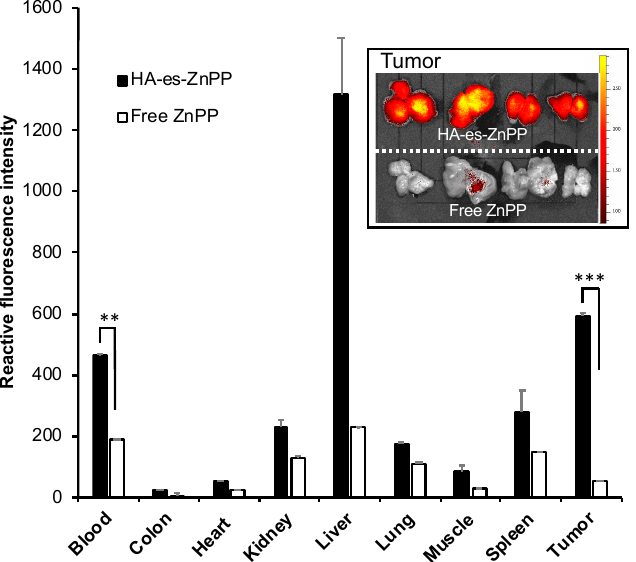
Figure 6. In vivo tissue distribution of HA-es-ZnPP in S180 solid tumor-bearing ddY mice. HA-es-ZnPP or free ZnPP was injected i.v. in the mice. After 24 h, mice were killed, and tissues, including tumors were collected. Tissue samples were homogenated using DMSO, and extracted HA-es-ZnPP or ZnPP in the supernatant was quantified by fluorescence spectroscopy. Inset shows the fluorescence images of mice-tumors treated with free ZnPP or HA-es-ZnPP . The tumors were cut in the middle of tumor nodules, and the cross-sectional views were shown. Data are mean ± SD. **, p < 0.01; ***, p < 0.001.